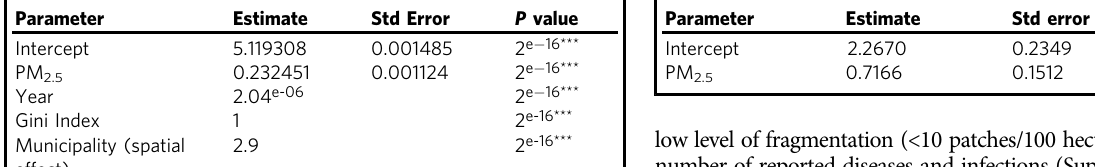
low level of fragmentation (<10 patches/100 hectares), the lower the number of reported diseases and infections (Supplementary Table 3 and Fig. 4). Our model also indicated that deforesting 1% of forest areas in each municipality could generate 82 new diseases and infections (with an error of ±4 cases). For the Indigenous territories,